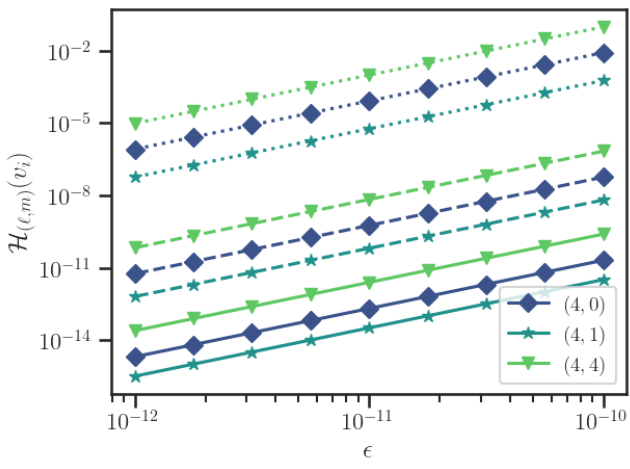
Figure 8 . Modes of H for different ( ‘, m ) at times v/M = 20 , 10 , 0 (solid, dashed,